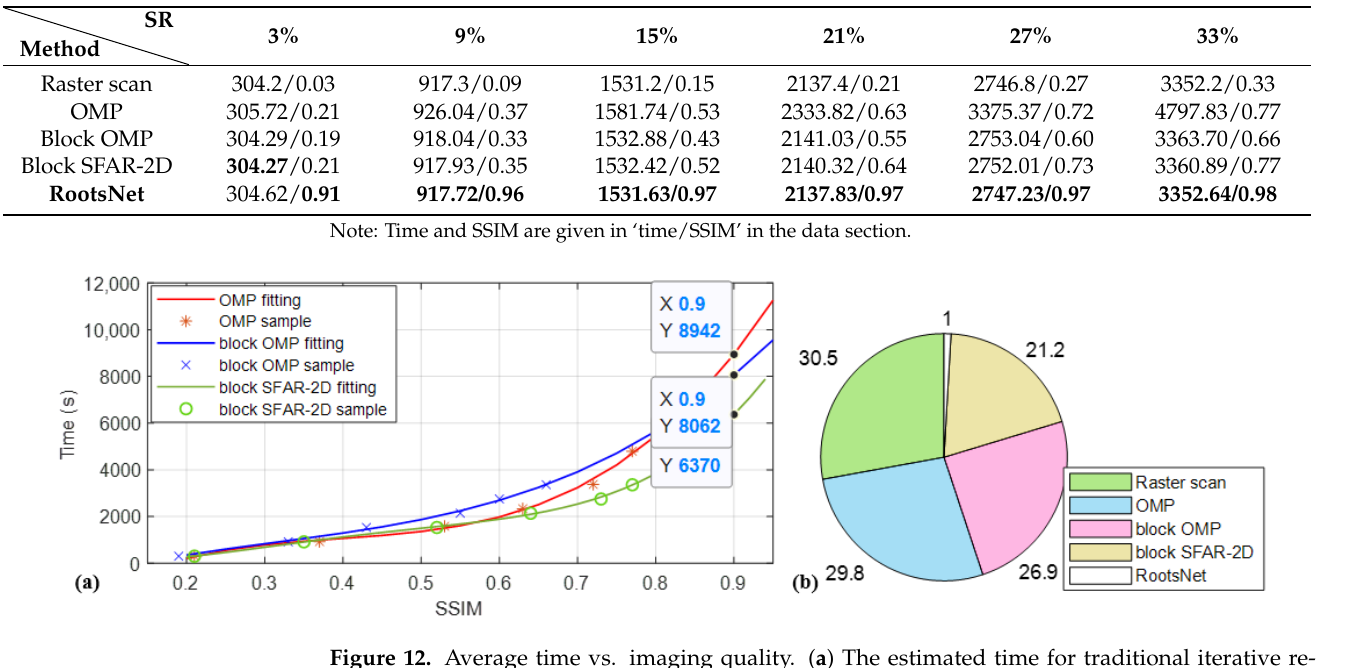
Table 2. Total time (in seconds) consumption and SSIM for different methods.